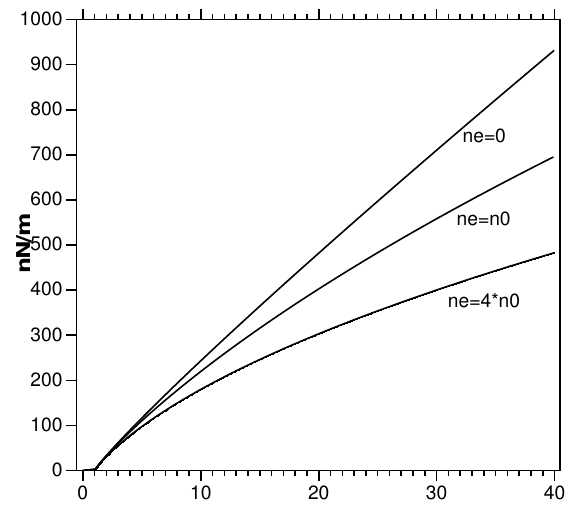
Fig. 12. Thrust per unit tether length (Eq. 34) for different assumed values of the electron density n e inside the